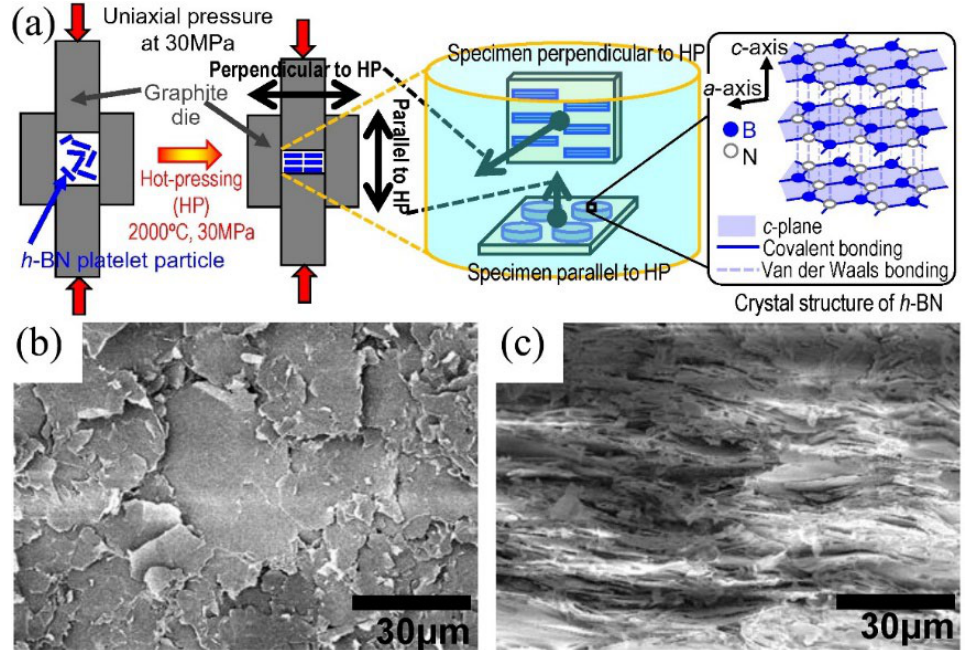
Fig. 8 Preparation and fracture morphologies of textured h-BN matrix ceramics prepared by HP: (a) schematic diagram of the preparation process; (b, c) fracture morphologies perpendicular and parallel to HP direction of textured h-BN ceramics sintered with 15 vol% Yb 2 O 3 –MgO additive, respectively. Reproduced with permission from Ref. [127], © Acta Materialia Inc.